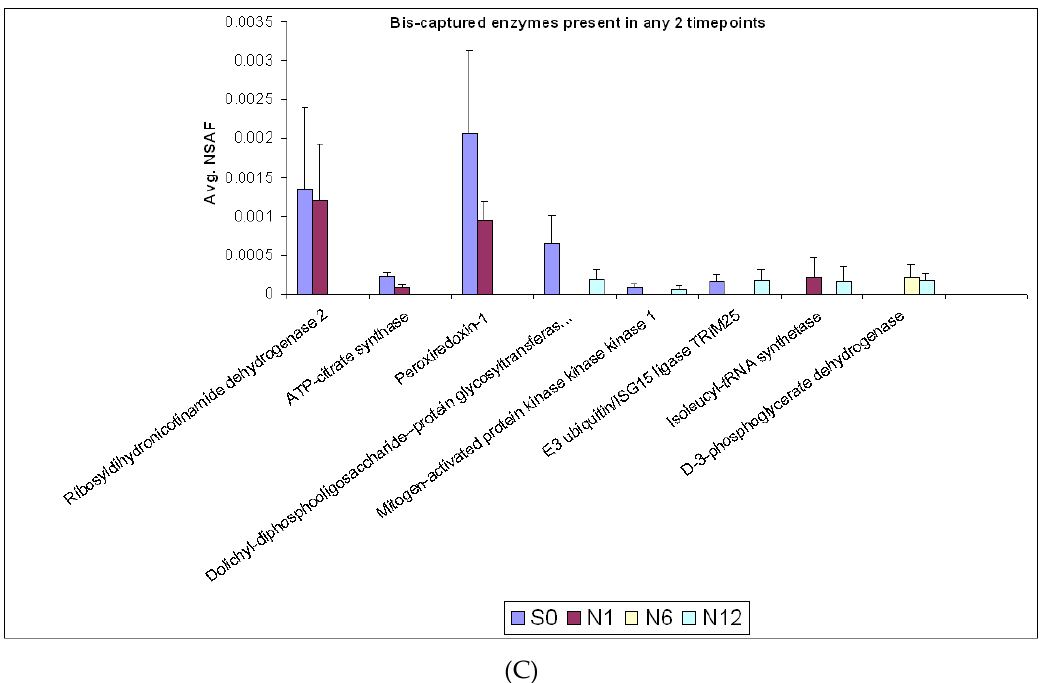
Figure 4. ( A ) Enzymes captured by the Bis-probe in all groups. Statistical analysis of the abundance levels of the proteins present in all the groups was analysed by a one-way ANOVA analysis. ( B ) Bis-bound enzymes present in any three time points Statistical analysis of the abundance levels of the proteins present in all the groups was analysed by a one-way ANOVA analysis. ( C ) Bis-bound enzymes present in any two time points. Statistical analysis of the abundance levels of the proteins present in all the groups was performed by a one-way ANOVA analysis.